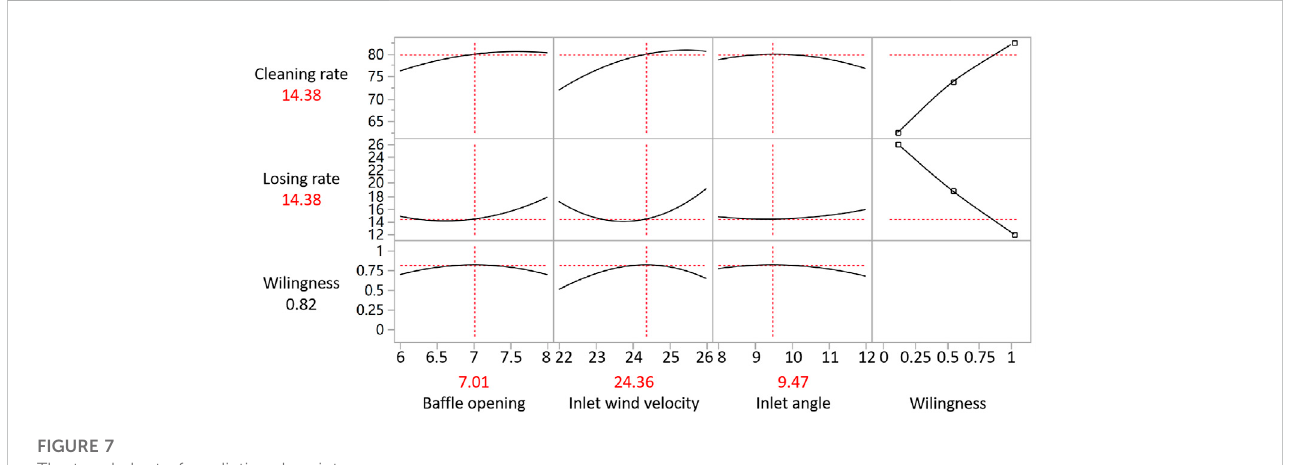
FIGURE 7 The trend chart of prediction